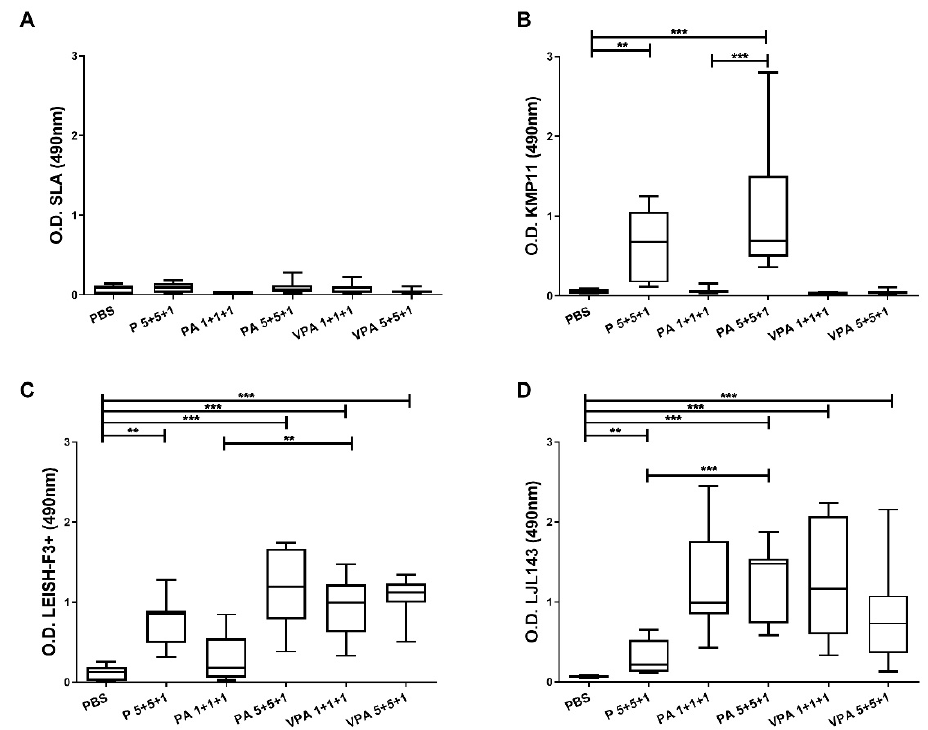
Figure 1. Humoral responses in immunized animals. Four weeks after the last immunization, IgG reactivity against L. infantum SLA ( A ), KMP11 ( B ), LEISH-F3+ ( C ), and LJL143 ( D ) was determined by ELISA in plasma from immunized hamsters ( n = 9 per group). Results are shown as whisker (min to max) plots. Statistical differences between groups are indicated (Mann–Whitney U test): ** p < 0.01; *** p < 0.001.